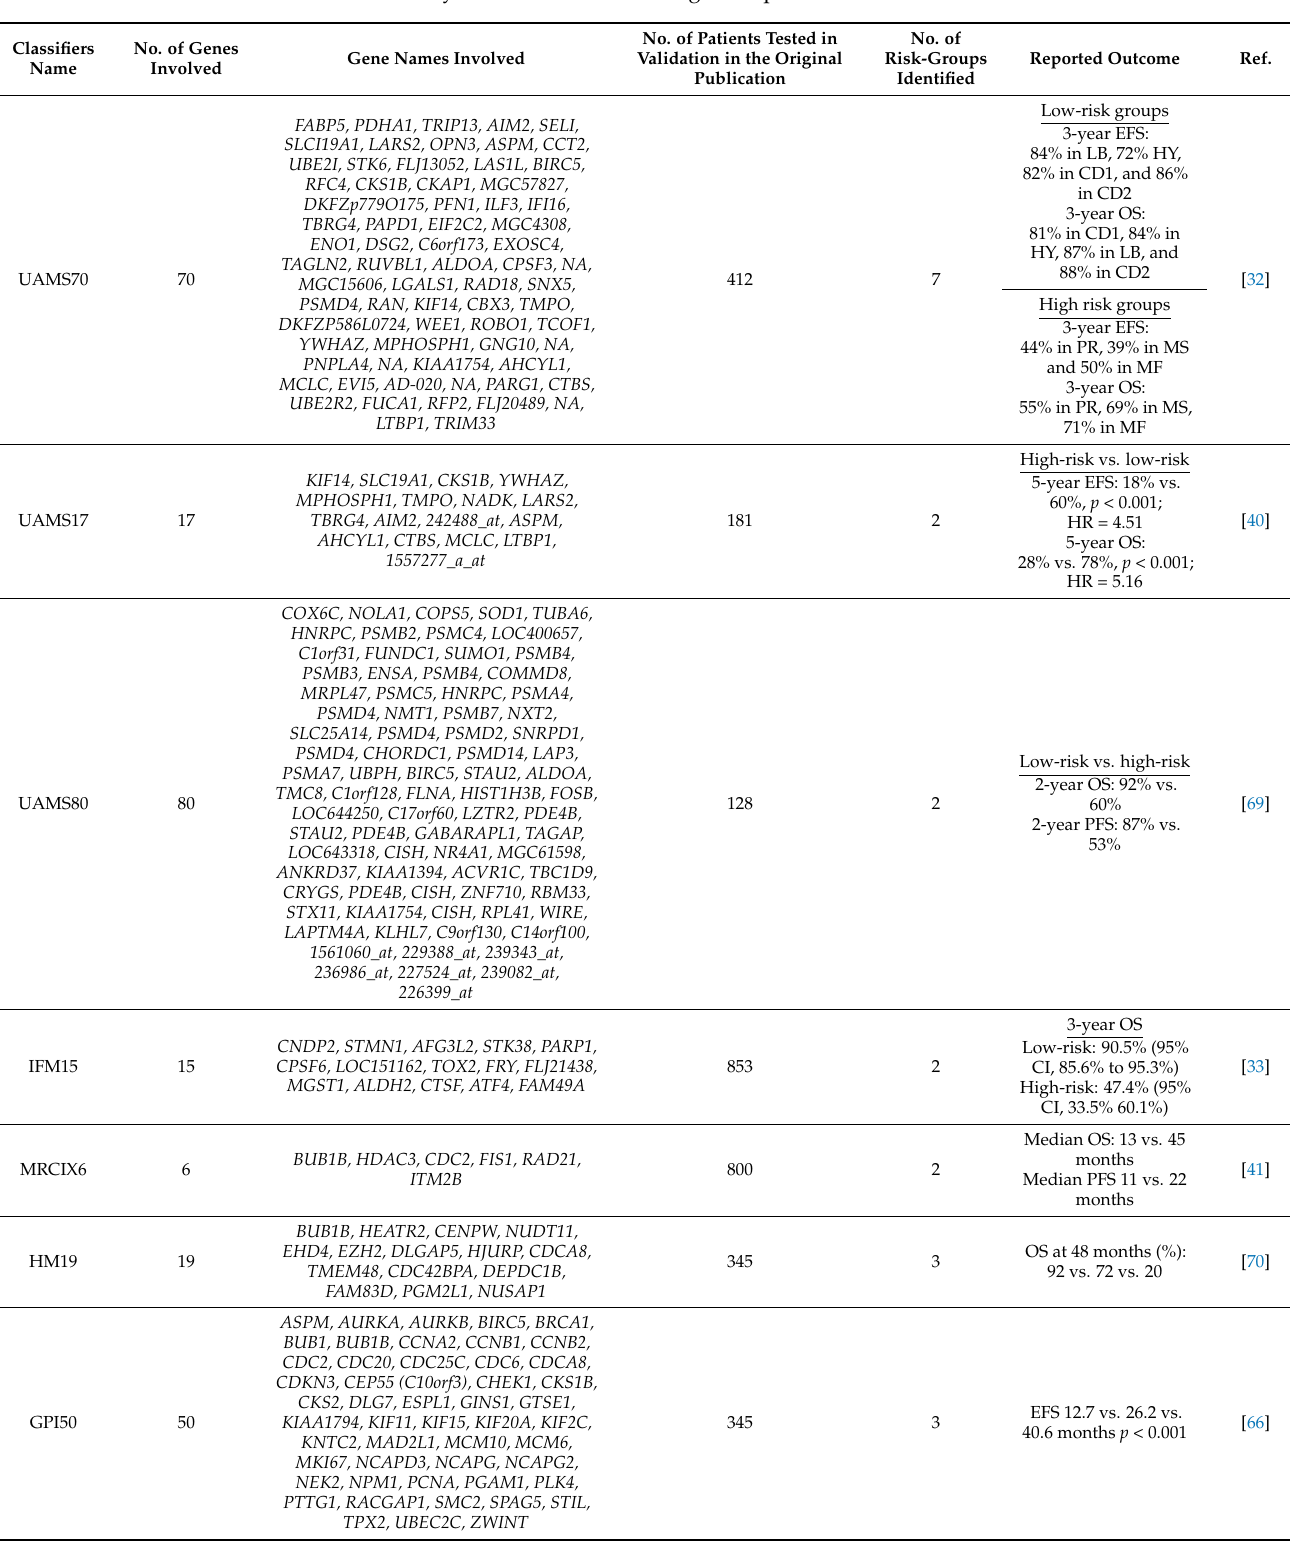
Table 2. Summary of differences between gene expression classifiers in